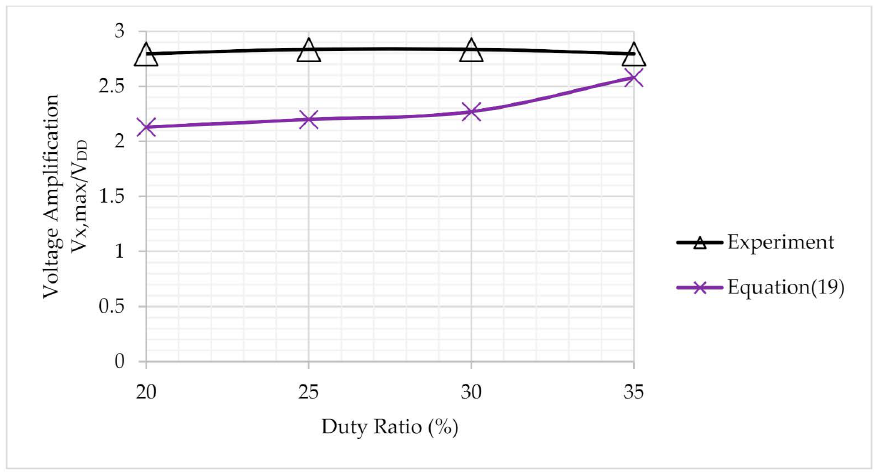
Figure 13. Comparison between the experiment and Equation